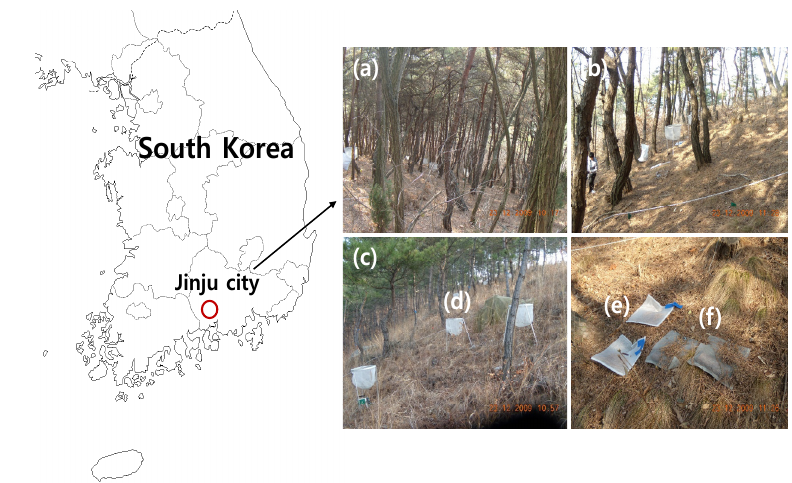
Figure 1. Location of the study site in pine wilt disease disturbed stands. ( a ) Slightly disturbed stand; ( b ) moderately disturbed stands; ( c ) severely disturbed stands; ( d ) litter trap; ( e ) needle litterbag; and ( f ) branch bag.